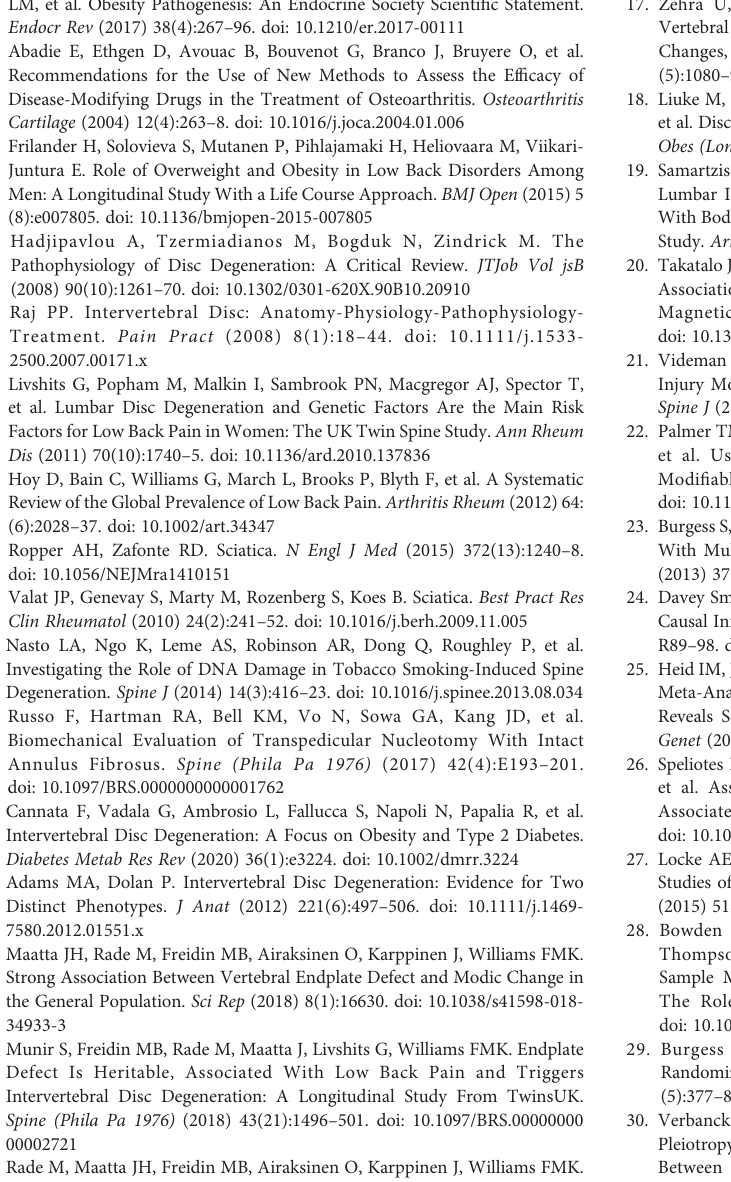
Supplementary Table 2 | Data source and detailed information of the included outcomes.